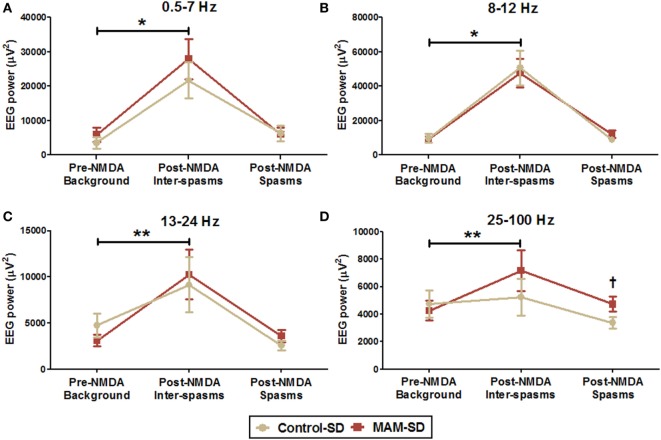
Quantitative spectral power analysis of electroencephalographies (EEGs) from methylazoxymethanol acetate (MAM)-exposed (n = 9) and saline-exposed rats (n = 9) before and after administration of a single N-methyl-d-aspartate (NMDA) dose (SD). (A,B) Mean EEG powers (μV2) of delta and theta (0.5–7 Hz) and alpha (8–12 Hz) frequency bands were significantly higher in the post-NMDA inter-spasms period than during the pre-NMDA background period for both groups. (C,D) The MAM-SD group exhibited higher EEG powers at the beta (13–24 Hz) and fast oscillation (FO; 25–100 Hz) bands during post-NMDA inter-spasms period than during the pre-NMDA period, while the control-SD group did not. (D) The EEG power of the FO band during spasms events was significantly higher in the MAM-SD group (4,721.9 ± 544.2 µV2) than in the control-SD group (3,374.0 ± 409.2 µV2, p = 0.047). Values expressed as mean ± SEM. *p < 0.05 using the Mann–Whitney U test for comparison between the pre-NMDA background activity and the post-NMDA inter-spasms in both two groups. **p < 0.05 using the Mann–Whitney U test for comparison between pre-NMDA background activity and post-NMDA inter-spasms in the MAM-SD group. †p < 0.05 using the Mann–Whitney U test for comparison between the groups.